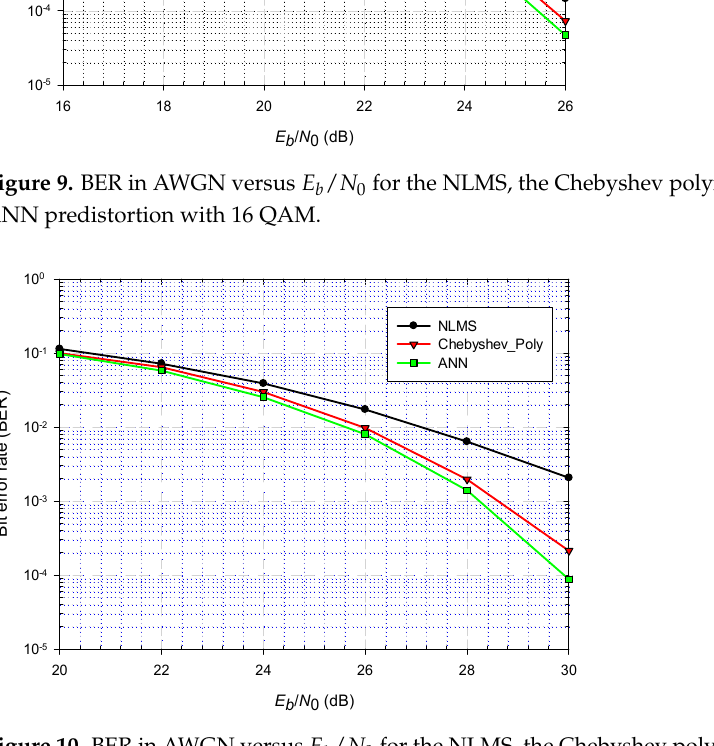
Figure 10. BER in AWGN versus 𝐸 (cid:3029) /𝑁 (cid:2868) for the NLMS, the Chebyshev polynomial, and the pro- posed ANN predistortion with 64 QAM.